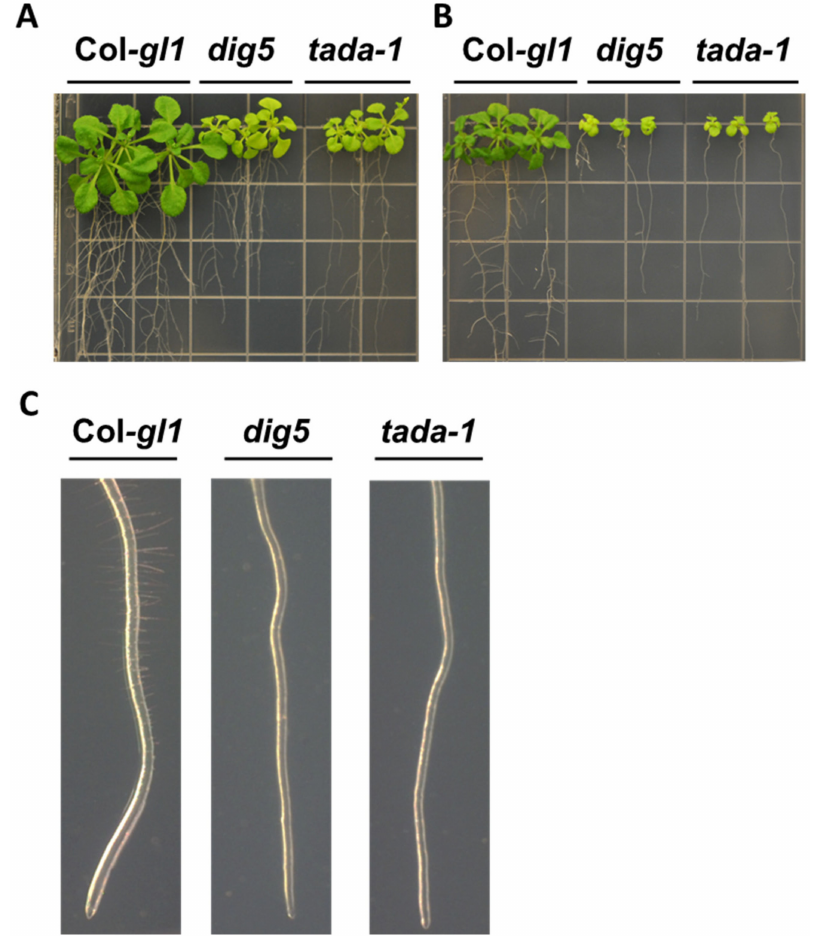
Figure 7. The mutant lines dig5 and tada- 1 had similar phenotypes. ( A , B ) Morphology of dig5 and tada- 1 seedlings on 1/2 MS without ( A ) or with ( B ) 1.0 µ M ABA. ( C ) Reduced numbers of root hairs of 10-day-old dig5 and tada - 1 mutant roots compared with the wild type